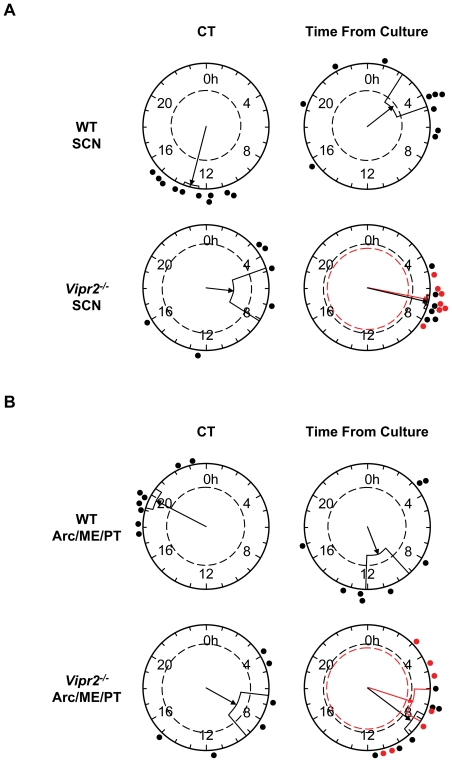
Rayleigh Plots Showing the Effect of Culture Preparation on Peak Phase of PER2::LUC Expression in SCN and Arc/ME/PT.Plots show peak PER2::LUC phase for WT and Vipr2−/− SCN and Arc/ME/PT plotted as either circadian time (CT; based on behavioral rhythms) or time of peak bioluminescence after culture preparation (Time From Culture). CT plots include data from behaviorally rhythmic mice only (black data points, arrow and dashed line) while time from culture plots show data both from behaviorally rhythmic (black) and arrhythmic (red) mice, analyzed separately. Black data points from behaviorally rhythmic mice on CT plots and time from cull plots are directly comparable. Red points from arrhythmic Vipr2−/− mice are included for subjective comparison. Both SCN and Arc/ME/PT from WT mice express peak PER2::LUC bioluminescence at a consistent circadian phase, regardless of cull/culture time (peak phase is correlated with CT not with time from culture). However, Vipr2−/− SCN and Arc/ME/PT always peak the same number of hours after culture preparation, showing these tissues to be reset by this process (peak phase correlated with time from culture not CT. Note that phase is well clustered for WT CT plots (upper left of panels A and B) and Vipr2−/− time from culture plots (lower right of panels A and B). Filled circles indicate the phase of peak bioluminescence in individual cultures. The direction of an arrow indicates the mean phase vector and its length shows significance relative to the (p = 0.05) significance threshold indicated by the inner broken circle. Boxes surrounding arrow heads show variance of phase between cultures.